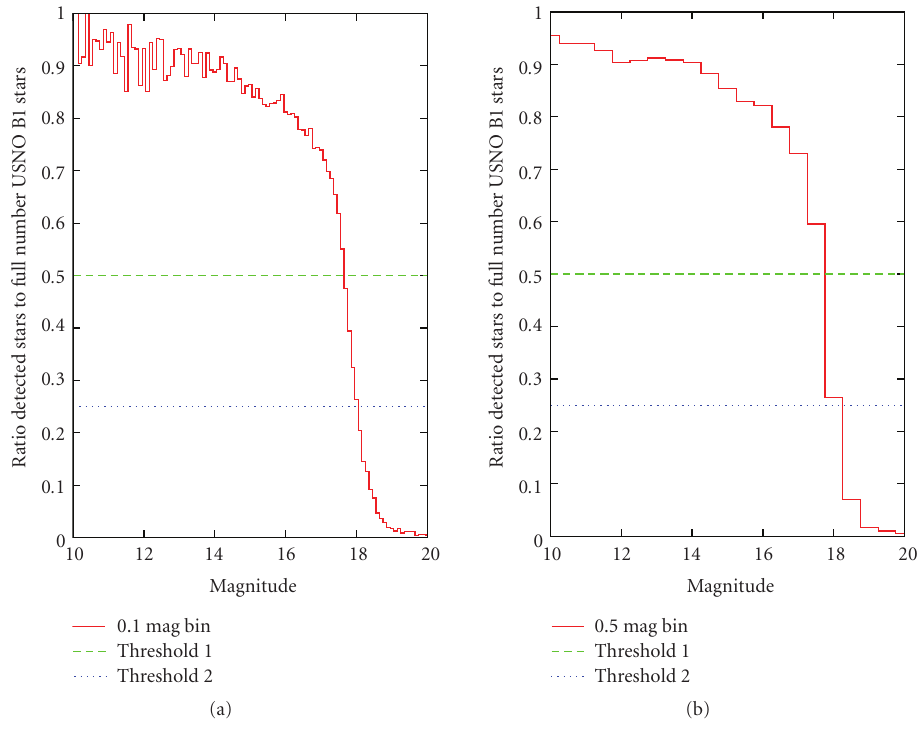
Figure 7: The number of identified stars as a function of magnitude. The straight lines indicate the σ lim = 50% and σ lim = 25% thresholds. Averaging was made within 0 . 5 m and 0 . 1 m bins in the right and left histograms, respectively. The right (coarser binned) histogram is smoother, resulting in reduced probability of accidentally reaching the threshold at a bright magnitude. It is therefore convenient to determine the limit on the coarsely binned histogram and then refine it on the finer-binned curve.